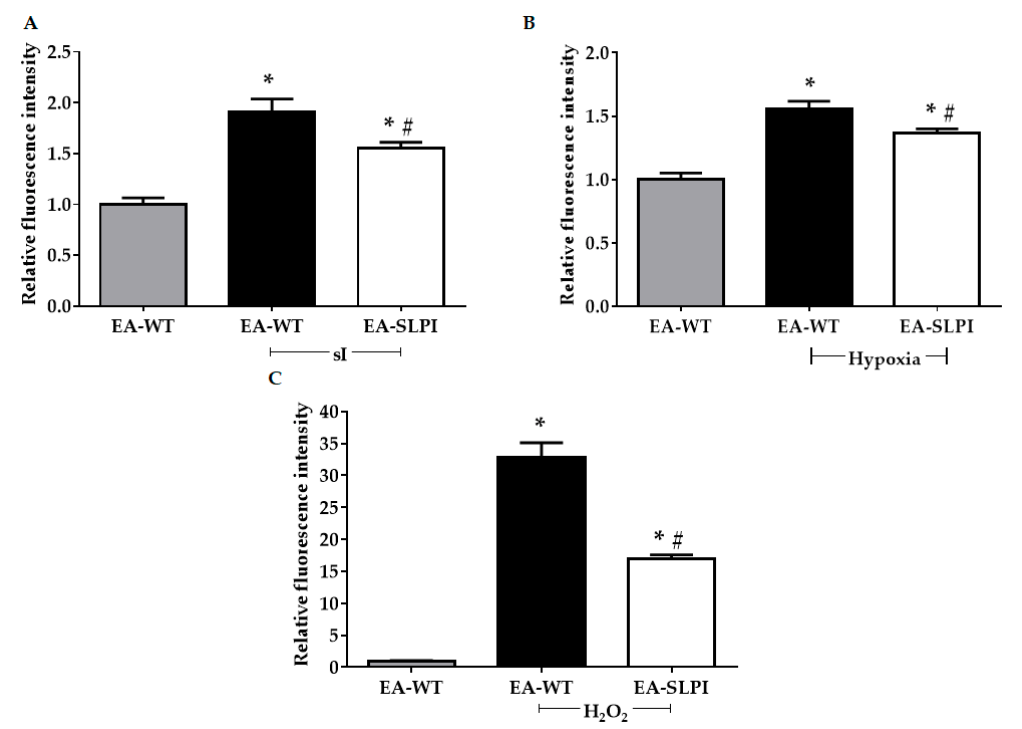
Figure 5. Determination of intracellular reactive oxygen species (ROS) levels in SLPI-overexpressing EA.hy926 cells. Wild-type (EA-WT) and SLPI-overexpressing (EA-SLPI) EA.hy926 cells were exposed to H2DCFDA followed by ( A ) sI/R or ( B ) H/R or ( C ) H 2 O 2 challenge. Then, the intracellular ROS level